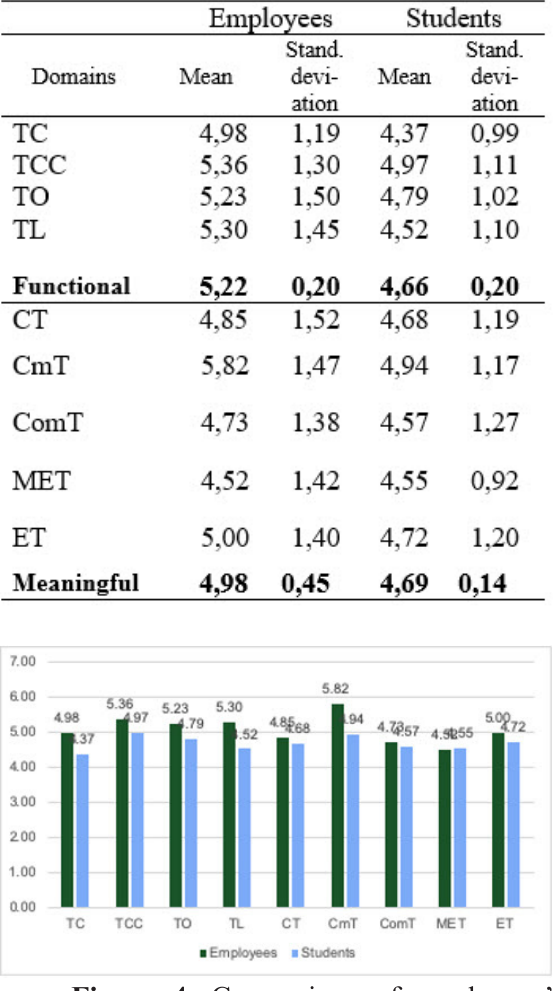
Figure 4. Comparison of employees’